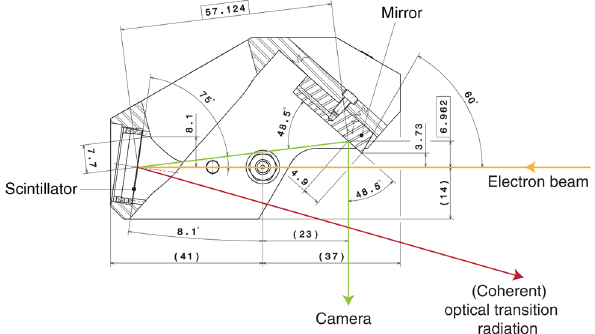
FIG. 5. Cross section of the screen mount, with the electron beam coming from the right. The angle from the normal of the scintillator is 8.1° to the beam axis, and 15° to the optical axis of the